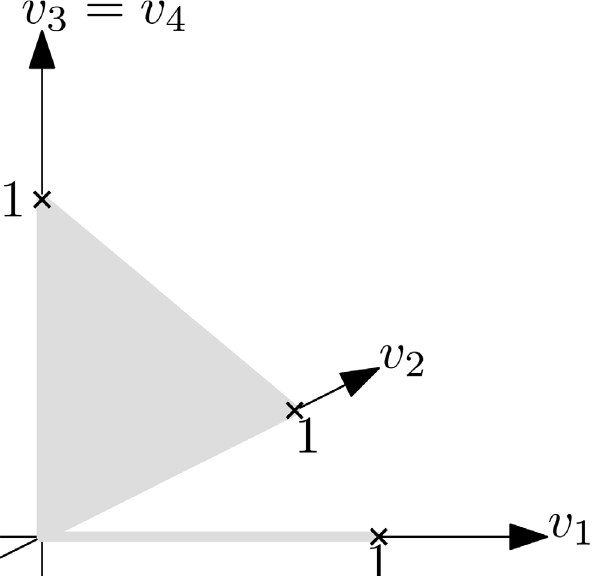
Fig 2. Flux space of toy network. The gray area denotes the flux space. In this example it was assumed that input/output flux values are constrained to at most 1. It can be seen that flux v 1 through r 1 is exclusive to fluxes v 2 and v 3 through r 2 and r 3 respectively. Since fluxes through r 2 can be combined with fluxes through r 3 , the flux space with v 2 , v 3 > 0 is two-dimensional, while the flux space with v 1 > 0 is only one-dimensional. Hence, a uniform sample of the flux space would almost surely have zero flux through r 1